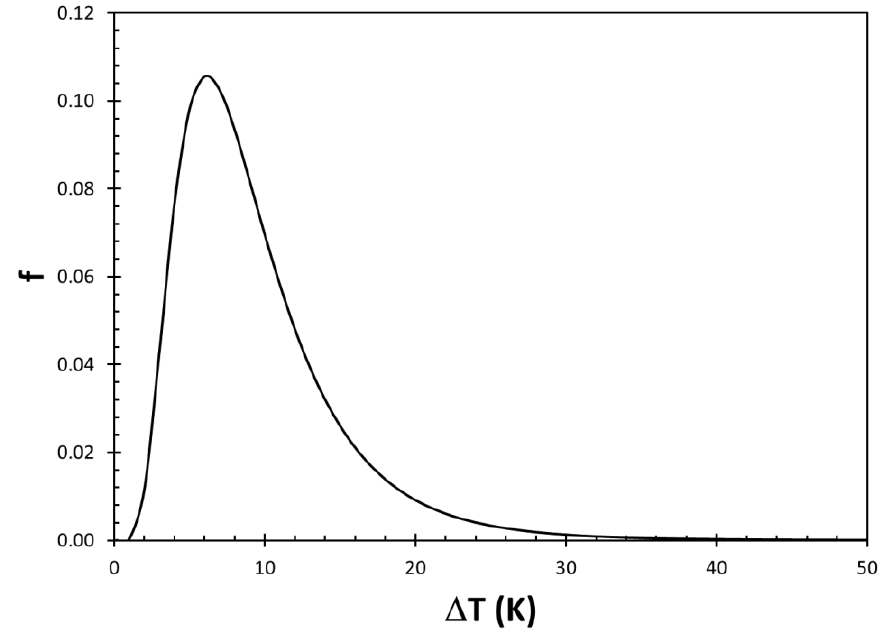
Figure 3. The lognormal distribution for the undercooling below the liquidus temperature for hydrogen pore formation during directional solidification of an Al-10wt.%Cu alloy.